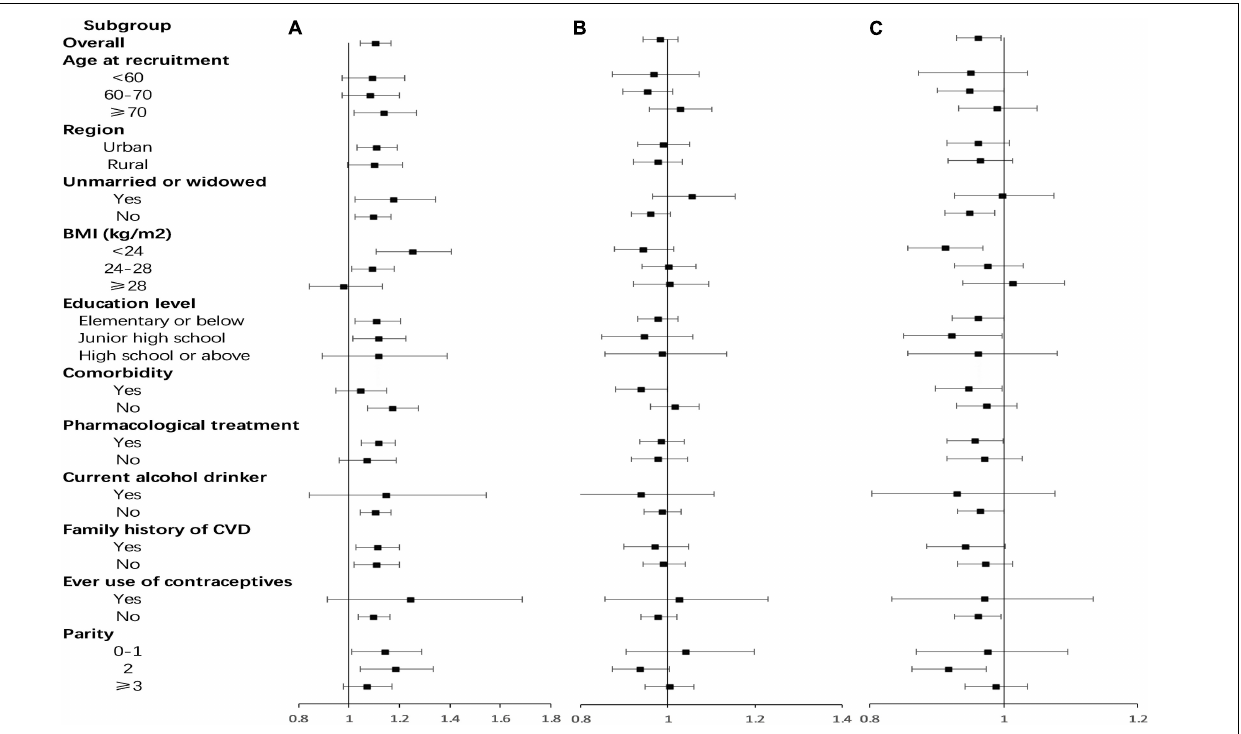
FIGURE 3 | Adjusted hazard ratios (HRs) for cardiovascular disease (CVD) per year by age at menarche, age at menopause, and reproductive lifespan within various subgroups. (A) Age at menarche; (B) age at menopause; (C) reproductive lifespan. Analyses were adjusted for age at recruitment, region, ethnicity, marital status, body mass index, waist circumference, education level, alcohol drinking, smoking, comorbidity, pharmacological treatment, family history of CVD, pregnant, contraceptive use status, and breastfeeding experience,